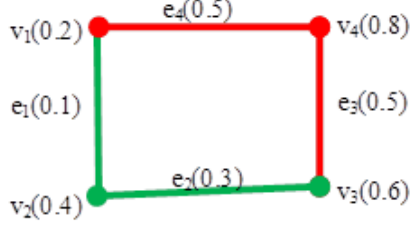
Figure 3.1: Arboricity of